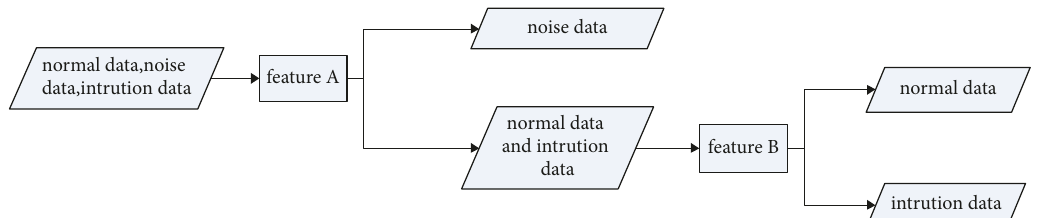
Figure 3: The function of feature A and feature